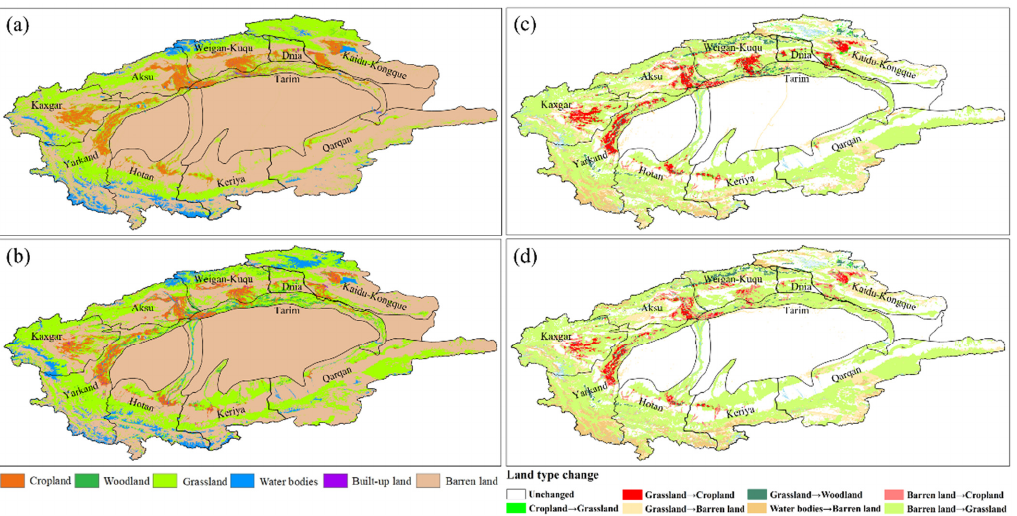
Figure 8. Future land changes in the Tarim River Basin: ( a ) 2019; ( b ): actual and simulated land-use change results of the CA-Markov Model for 2030; ( c ) 2019–2030; ( d ): future land-use type transfer for 1990–2030.